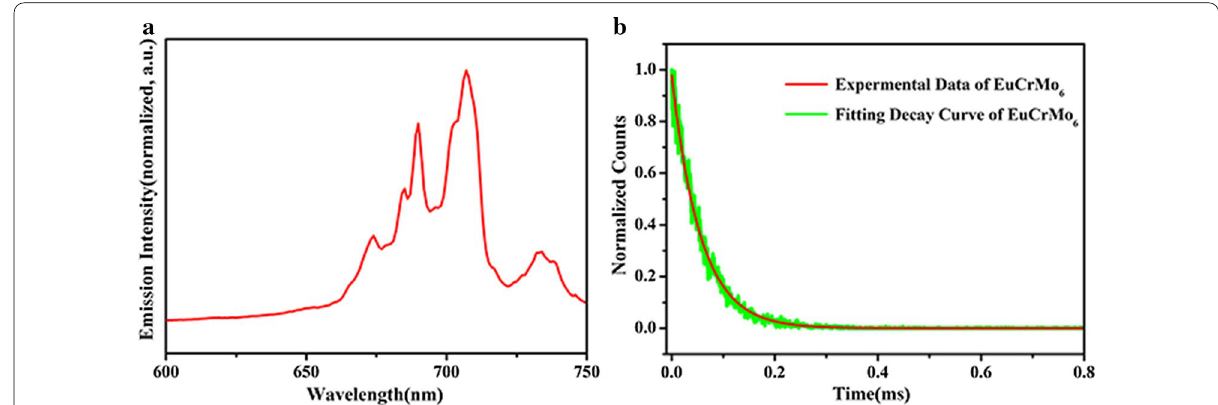
Fig. 15 a Emission spectrum of EuCrMo 6 ; b PL decay curve of EuCrMo 6